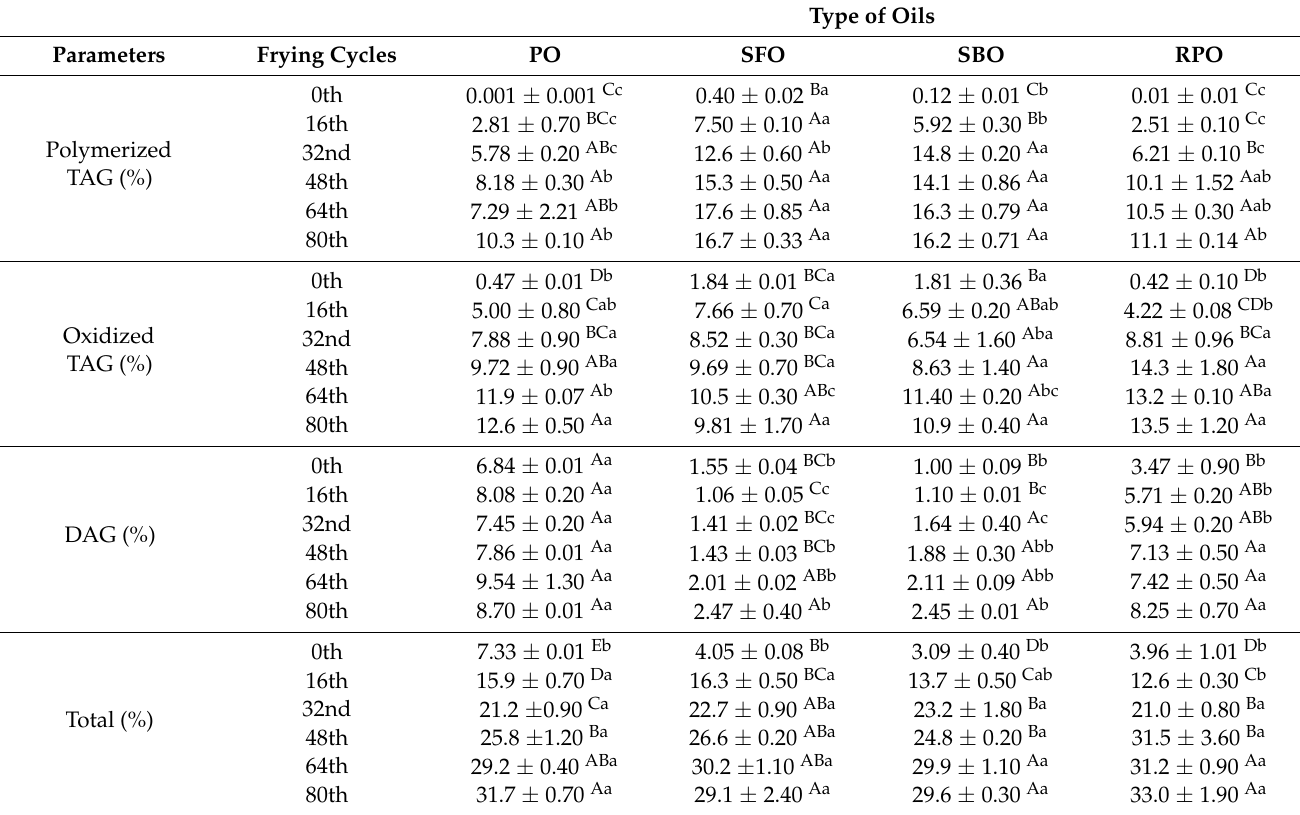
Table 3. Changes in polar fractions of different vegetable oils across 80 frying